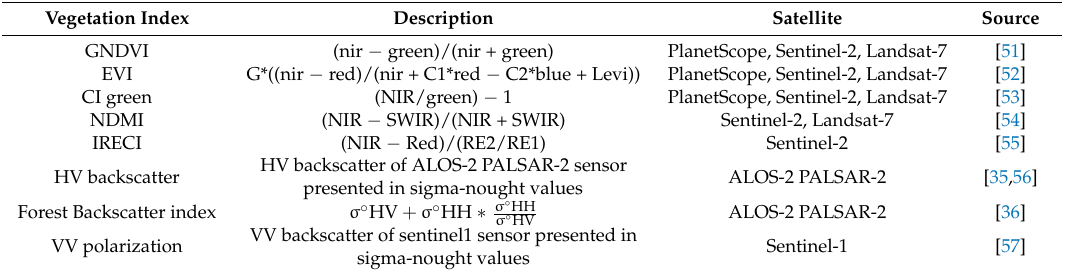
Table 3. Equations used for the calculation of vegetation indices from satellite remote sensing dataset. Vegetation